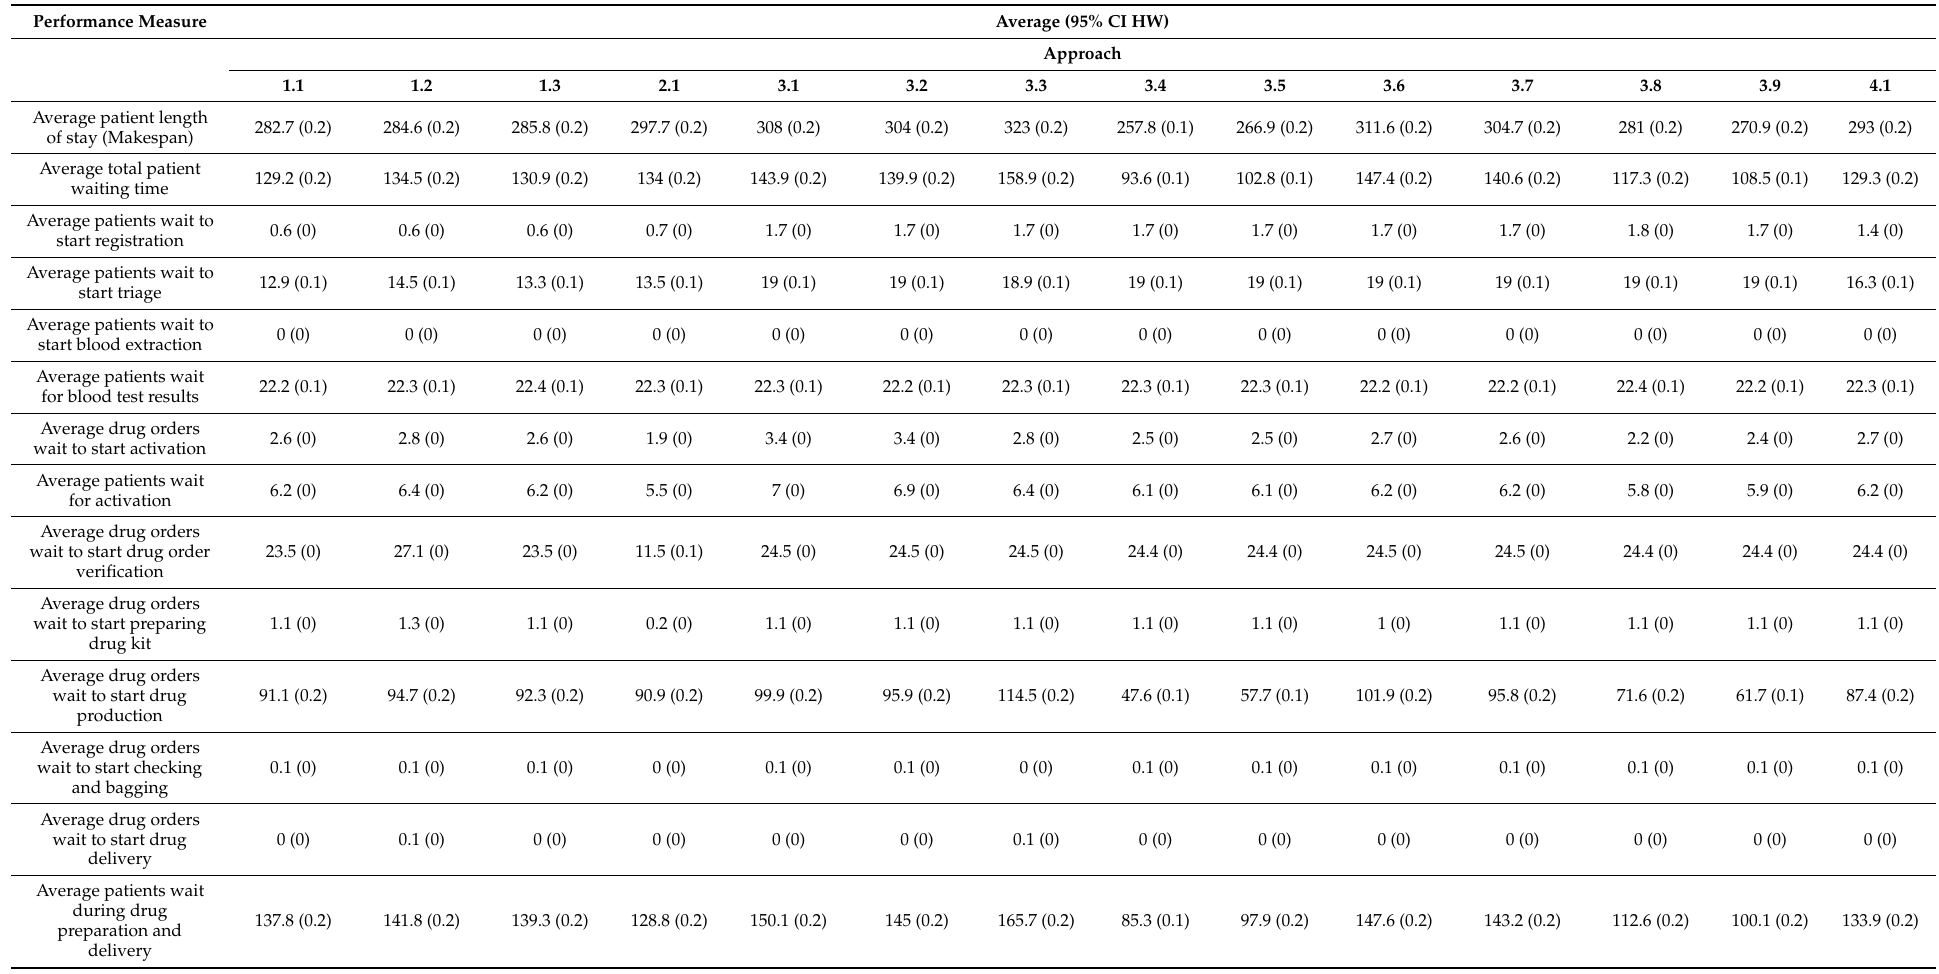
Table A3. Results of post-optimization analysis of performance measures using Monte Carlo